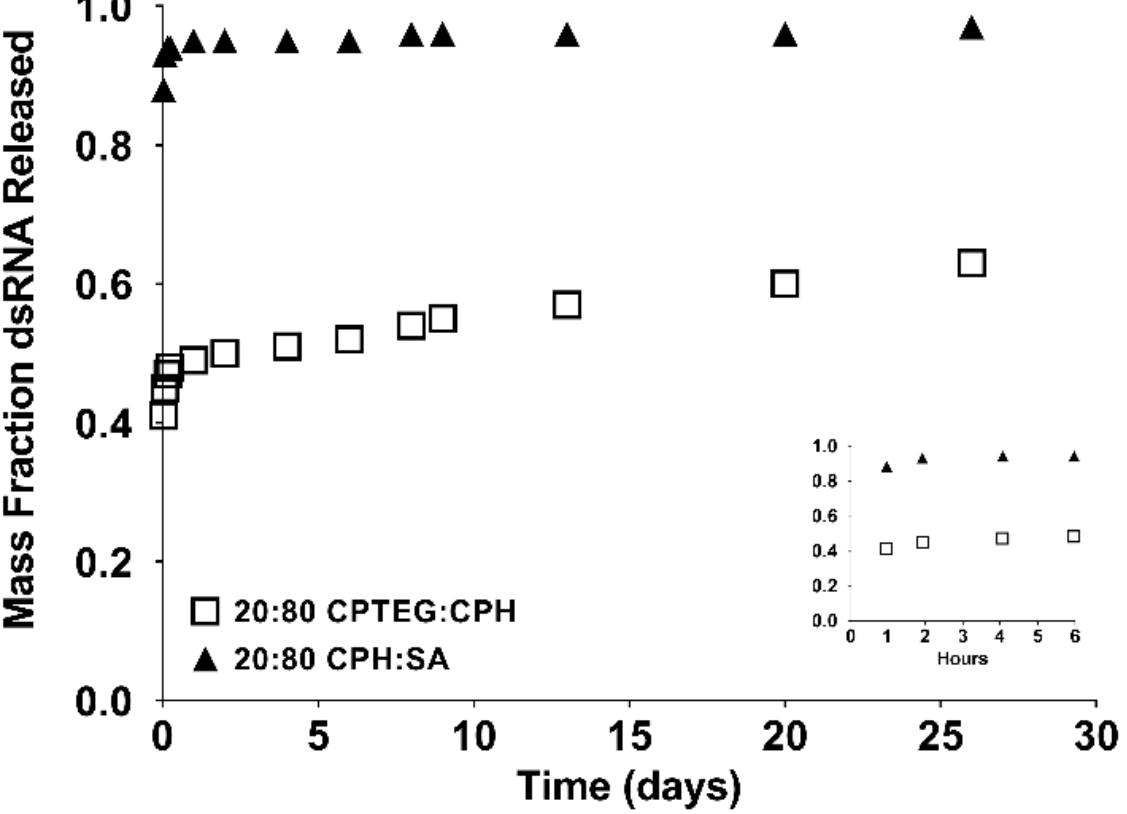
Figure 1. In vitro release kinetics of dsRNA-loaded nanoaparticles. Nanoparticles loaded with 11% WSSV 477 dsRNA were incubated in saline for approximately 1 month and the release kinetics were measured. Data are presented as the mean ± standard error of the mean (SEM) and are representative of 3 replicates per formulation.